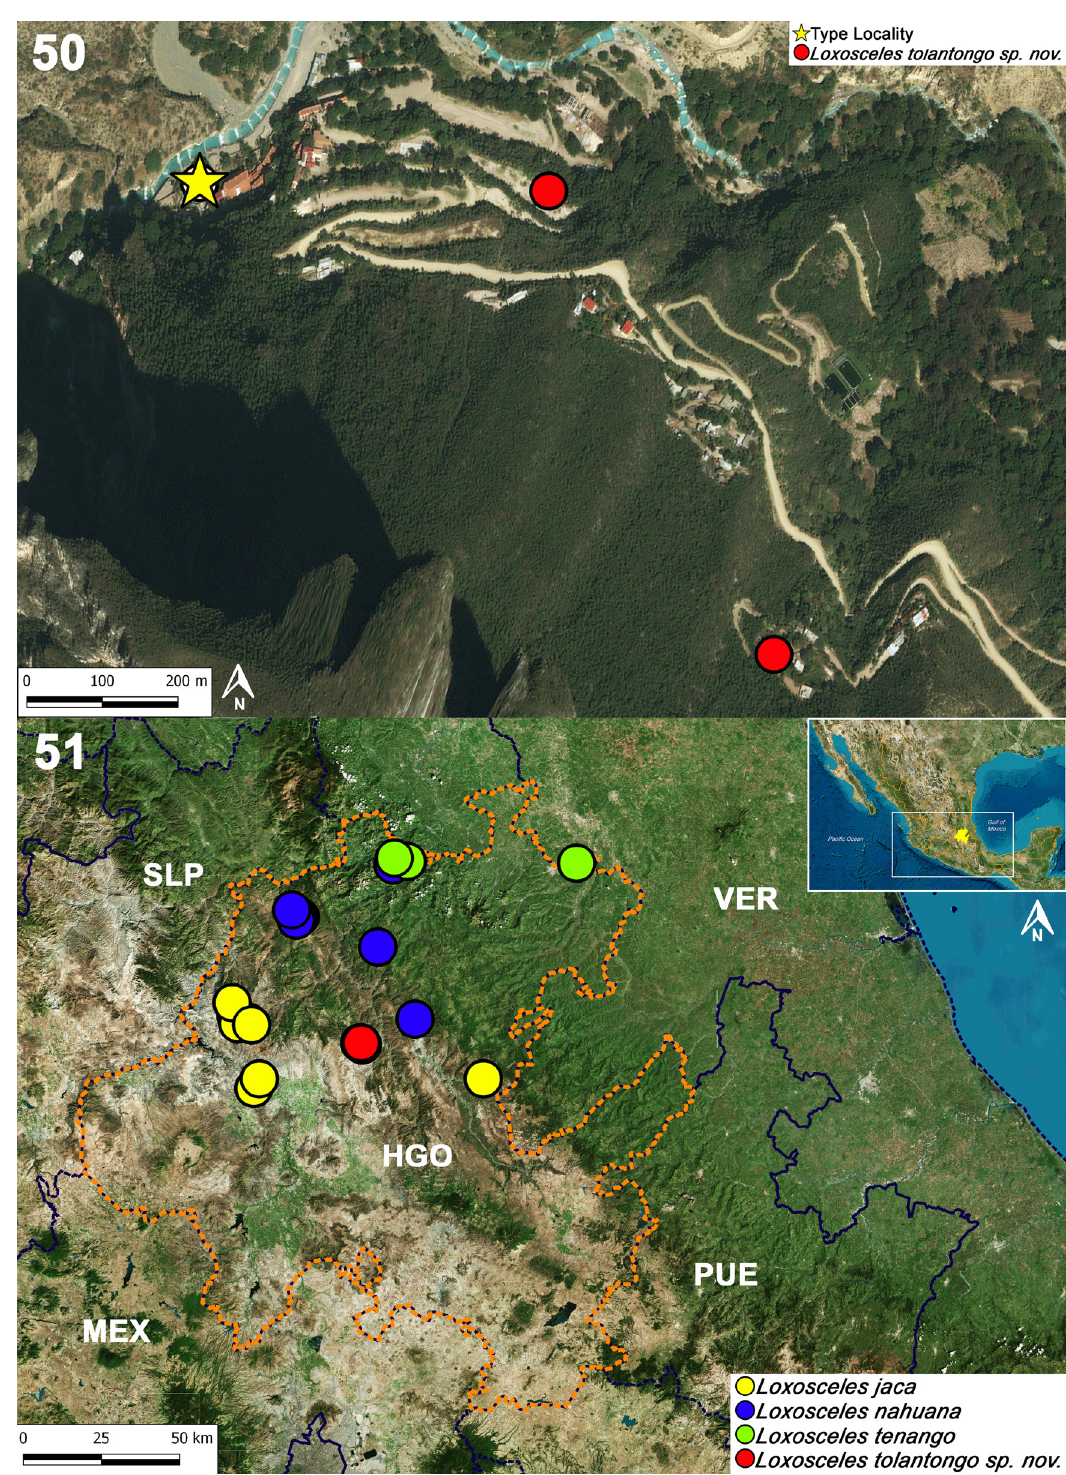
Figs. 50–51. Distribution records of Loxosceles tolantongo sp. nov. from Hidalgo. 50 . Known records of Loxosceles tolantongo sp. nov. from the Tourist Center Grutas de Tolantongo, Municipality of Cardonal, Hidalgo, including the type locality. 51 . Distribution records of the four species of Loxosceles from Hidalgo, Mexico. Abbreviations: HGO = Hidalgo; MEX = Estado de Mexico; PUE = Puebla; SLP = San Luis Potosí; VER =